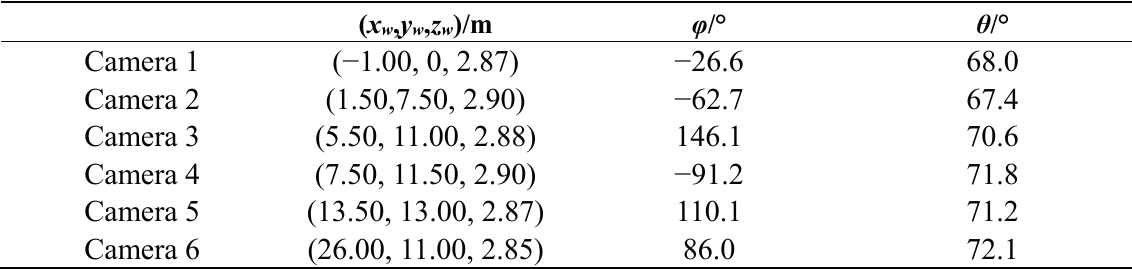
Table 3. Geometrical parameters of